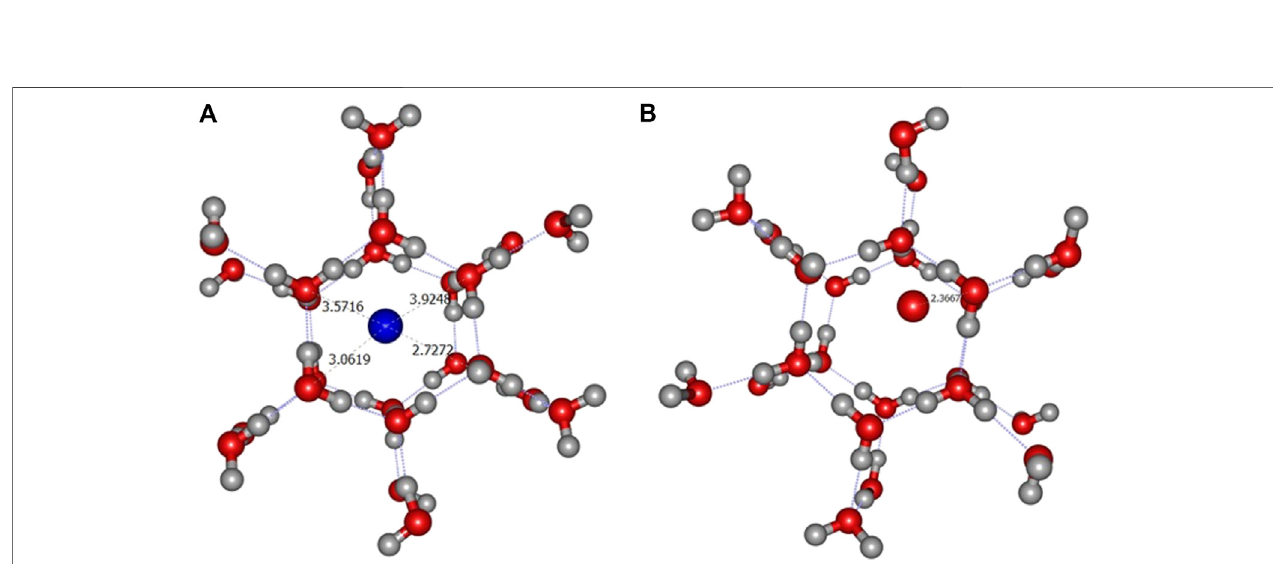
FIGURE 4 | ONIOM( ω B97X-D/6-31+G**:PM6) most stable geometry for N (A) and O (B) atoms (A2 site) on crystalline ice.